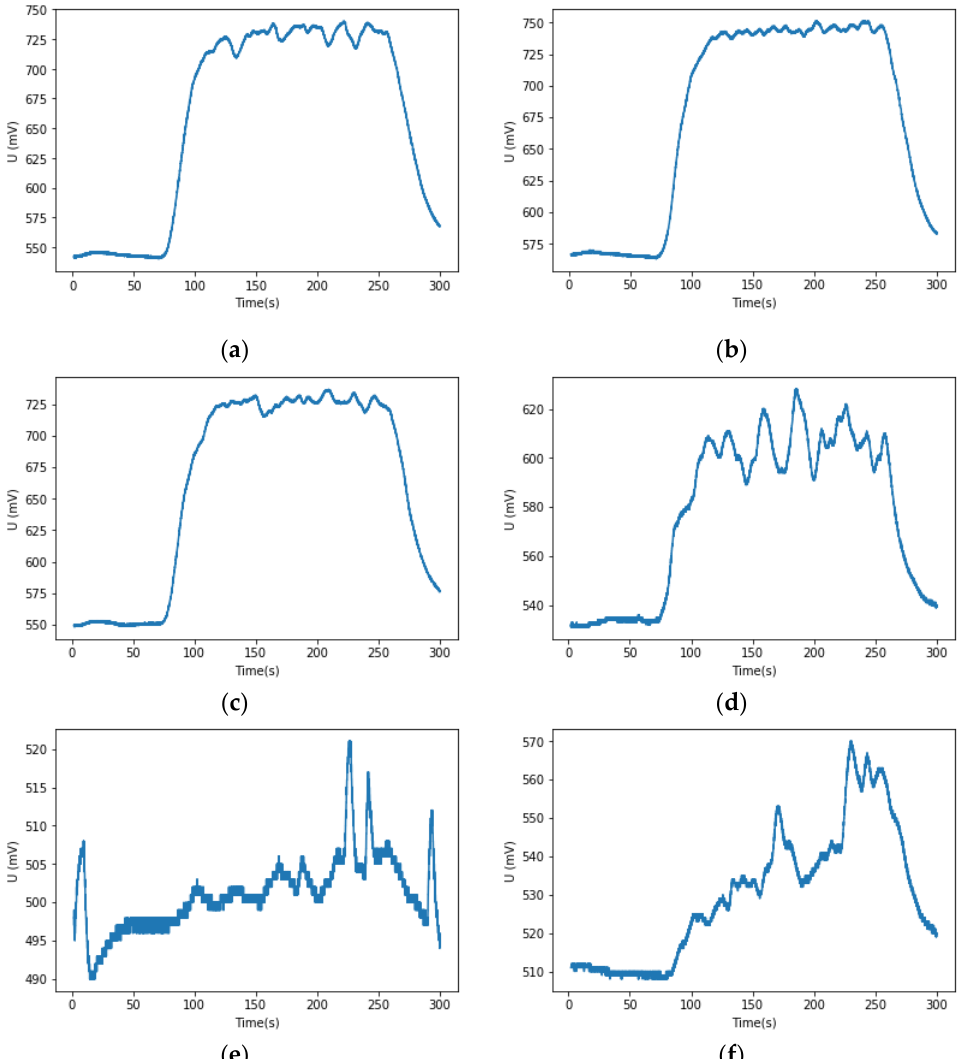
Figure 6. Et_M_Me_M TGS2602 response curves. ( a ) First experiment response curve; ( b ) Second experiment response curve; ( c ) Third experiment response curve; ( d ) The fourth experiment response curve; ( e ) The fifth experiment response curve; ( f ) The sixth experiment response